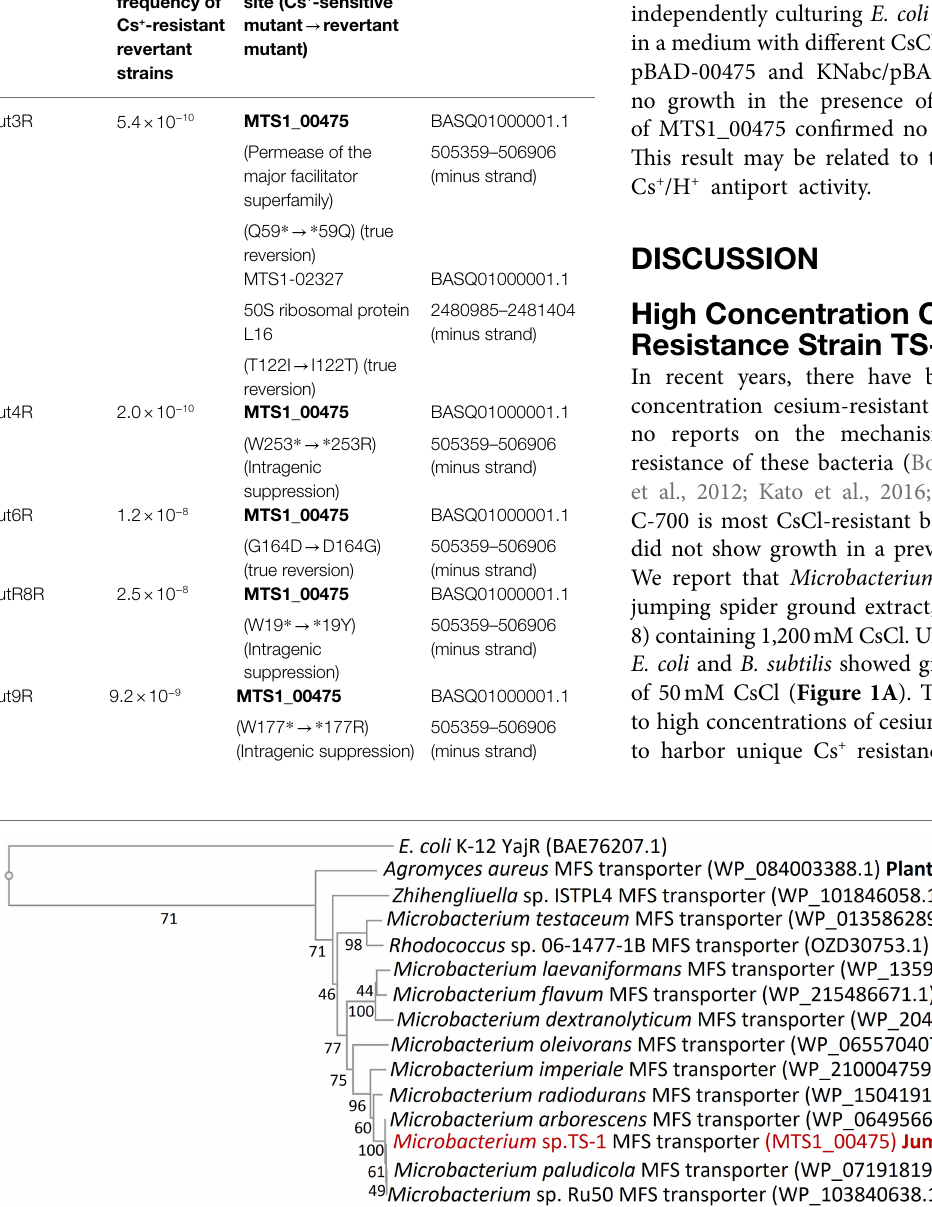
TABLE 2 | The reversion mutation rates of each Cs + -sensitive mutant strain proteins encoded by genes with revertant mutations in each revertant mutant. Mutants The frequency of